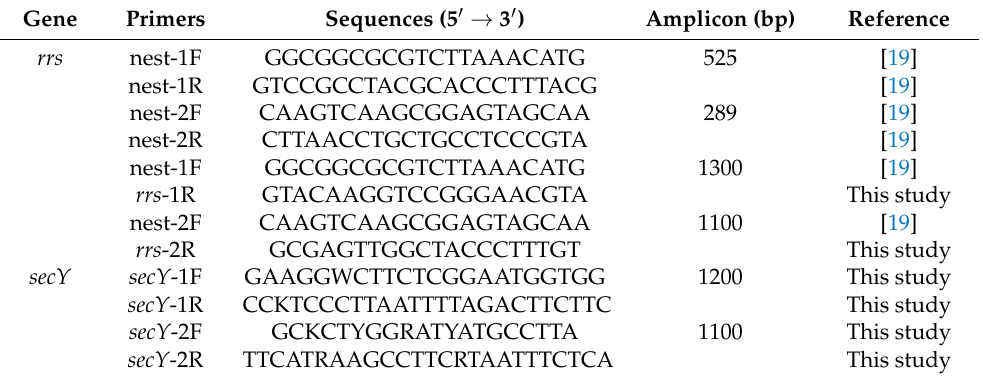
Figure 1. Geographic maps showing the location of sampling sites from where the rodents were captured in this study. This map was plotted using a combination of Surfer software, Version-4 (Golden Software, Golden, CO, USA), and Adobe illustrator, Version CC2017 (Adobe, San Jose, CA, USA). The black dots indicate the sampling regions in this study. Table 1. Primers used in this